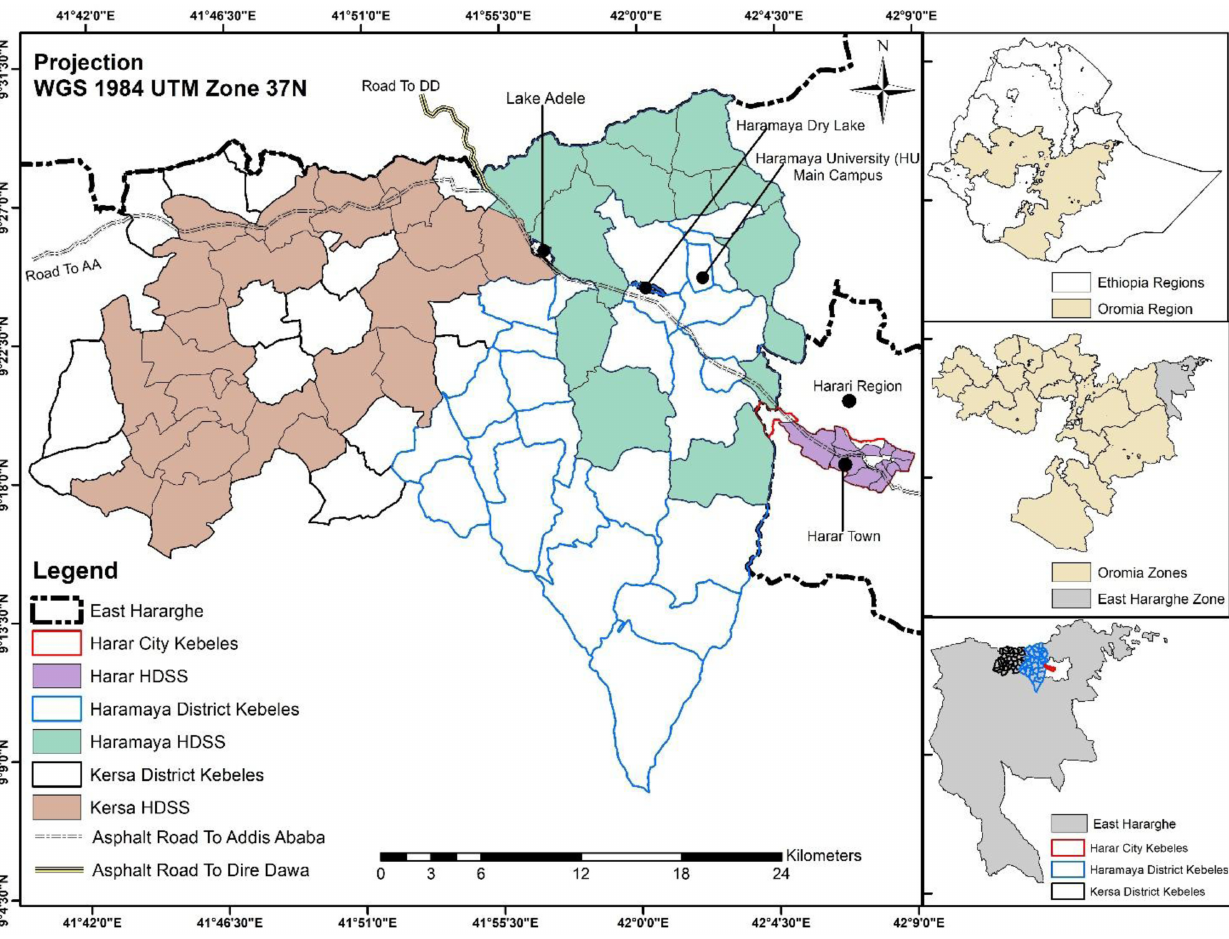
Figure 1. Harar, Kersa and Haramaya Demographic Surveillance Sites (DSS) are within East Hararghe, Oromia,